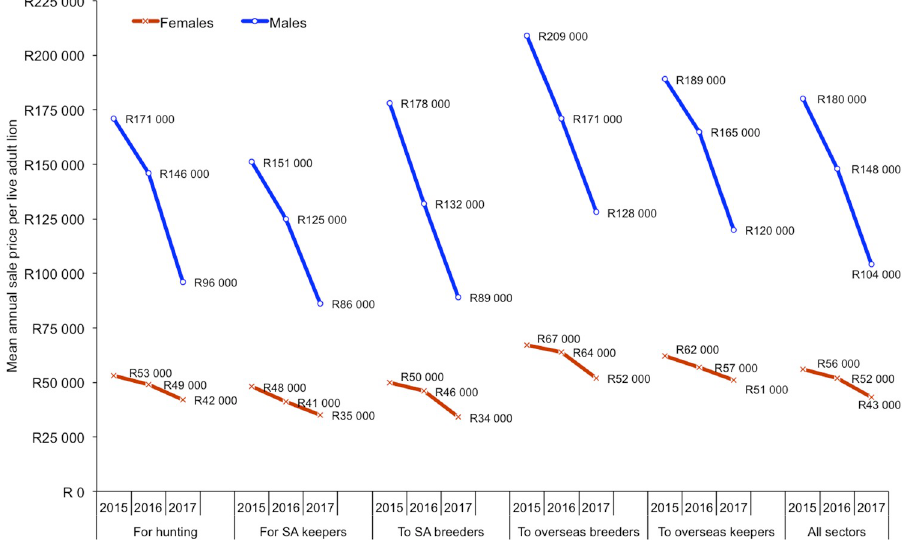
Fig 5. The mean annual sale price of a live adult lion per purpose (rounded up to the nearest R1000). All means, medians, standard deviations and sample sizes are in Tables L & M of S1 Tables, and Figures J & K in S1 Figs. Graph showing values in USD in Figure I in S1 Figs, where mean annual ZAR:USD exchange rates: 2015 (1: 0.078); 2016 (1: 0.068); 2017 (1: 0.075). Results correspond to Questions 41–43.